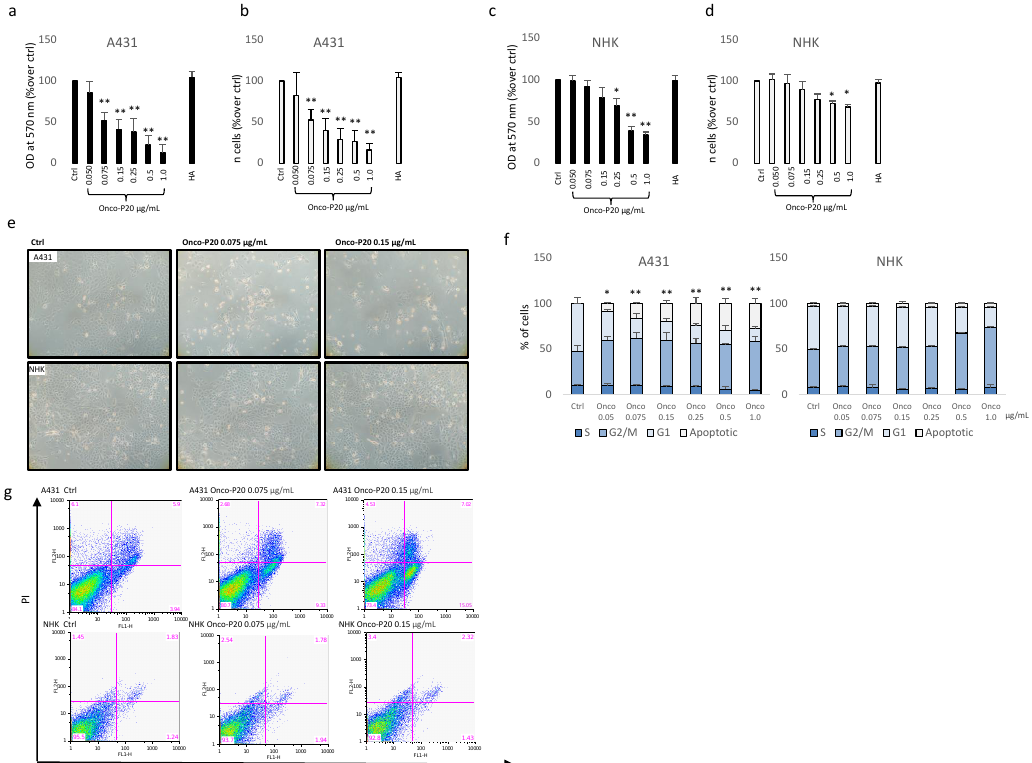
Figure 1. MTT assay ( a ) and cell count ( b ) of A431 cells treated (72 h) with increasing concentrations of Onco-P20 (range 0.05–1.0 µ g/mL) or HA 1.0 µ g/mL, equivalent to the HA concentration at the higher doses of Onco-P20. Data are reported as optical density (OD). Data represent the mean ± SD of three independent experiments performed in duplicate. MTT assay ( c ) and cell count ( d ) of NHKs treated (72 h) with increasing concentrations of Onco-P20. Histograms represent the mean ± SD of three NHK cell lines isolated from different donors. ( e ) Microscopic images of normal and carcinoma cells after 72 h of treatment with Onco-P20. ( f ) Cell cycle distribution of Onco-P20-treated normal and carcinoma cells. ( g ) Apoptosis was evaluated by FACS analysis using annexin V/iodide propidium staining. Dot plots show one representative experiment performed 24 h after Onco-P20 treatment. Statistical significance versus untreated control is reported as * p < 0.05 and ** p < 0.001. In the case of ( g ), statistical significance represents the difference of apoptotic cells in A431 versus